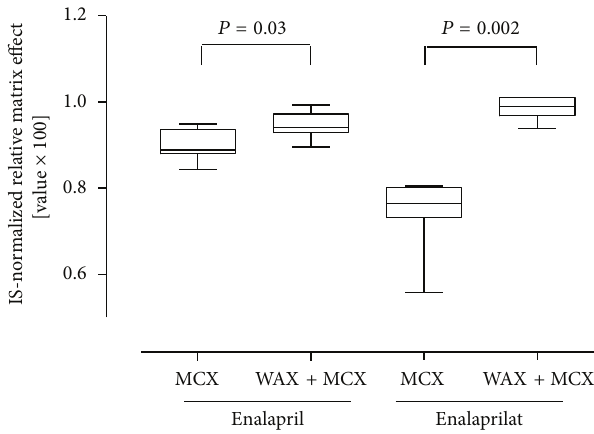
Figure 3: Determined split peak in serum with the transition 349.1 → 206.1 m/z duringmethoddevelopment.Thesplitpeakwas measured on several HPLC columns after SPE purification by Oasis MCX. In grey, the ion count of a low enalaprilat concentration in serum is shown that clearly identifies the split peak. As reference, the enalaprilat standard solved in mobile phase is presented by the black line without any split peak (base line is nudged to prevent overlap).